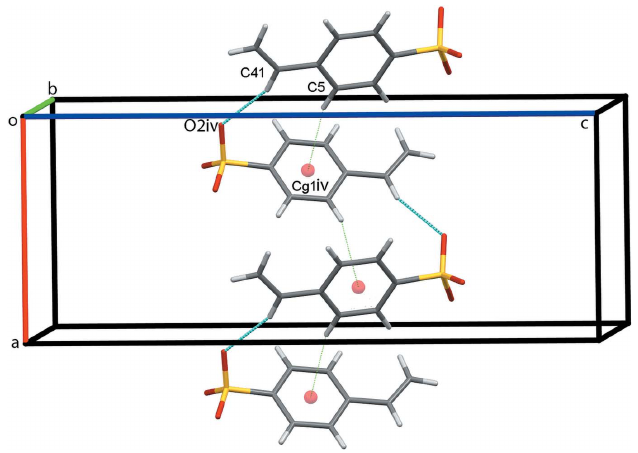
(cid:3) z ; (iii) + y , 1 2 2